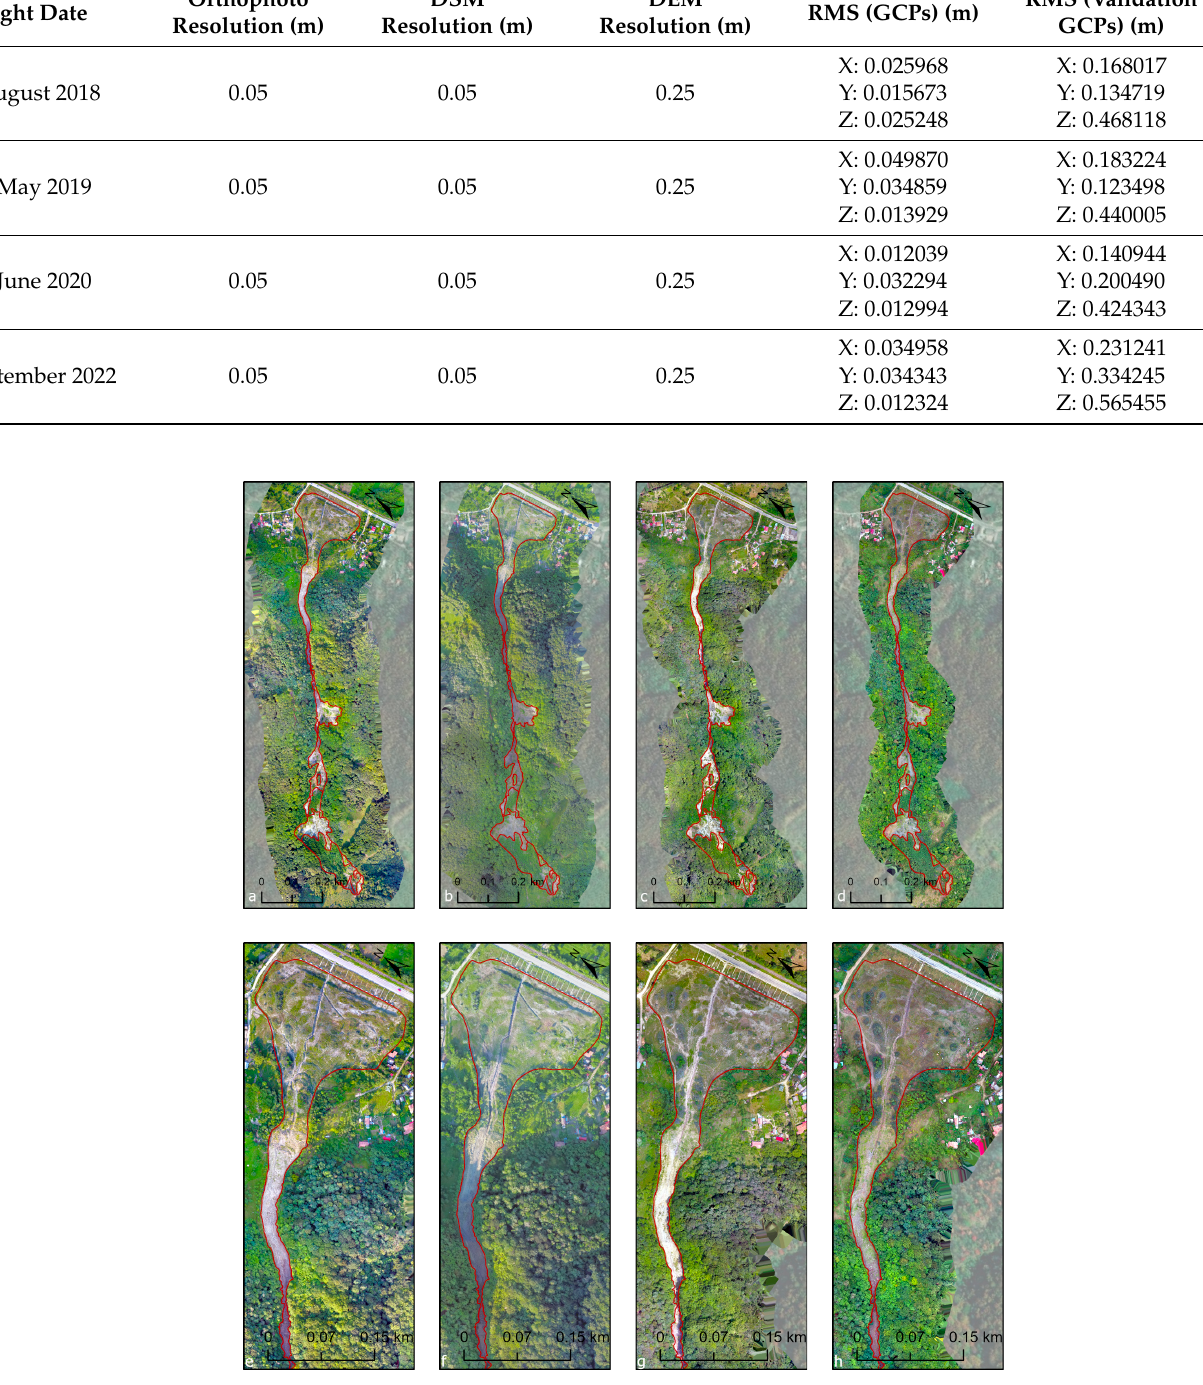
Figure 7. Chirles ti earthflow. In the first row, from left to right, each image represents a different , acquisition date where: the entire earthflow, each flight from left to right corresponds to 2018 ( a ), 2019 ( b ), 2020 ( c ), and 2022 ( d ); on the second row, the contact between transport and accumulation area is presented. The same acquisition date is valid from left to right (2018 ( e ); 2019 ( f ); 2020 ( g ); 2022 ( h